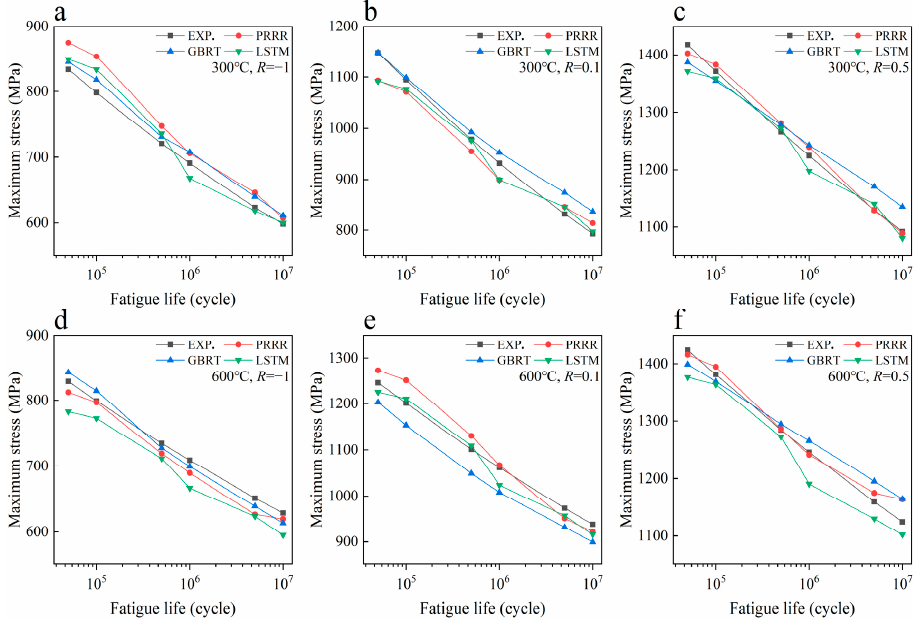
Figure 9. Predicted results of different machine learning models for the fatigue strength of the nickel-based superalloy under different conditions in case 4: ( a ) 300 ◦ C, R = − 1; ( b ) 300 ◦ C, R = 0.1; ( c ) 300 ◦ C, R = 0.5; ( d ) 600 ◦ C, R = − 1; ( e ) 600 ◦ C, R = 0.1; ( f ) 600 ◦ C, R =